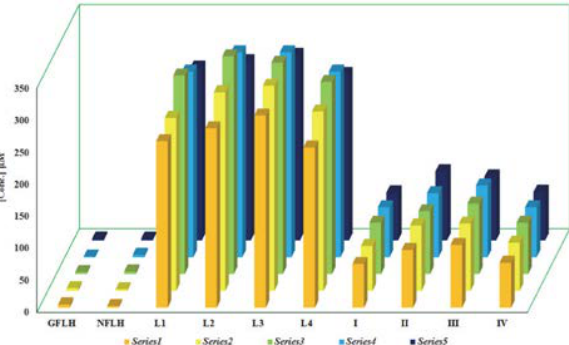
Figure 7. Minimum inhibition concentration (MIC) values of syn- thesized compounds given in